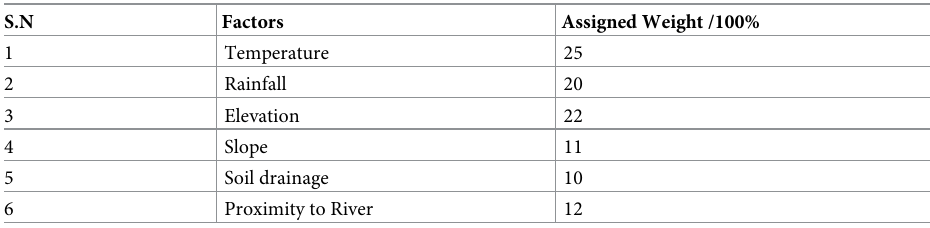
Table 2. Weight assigned for the